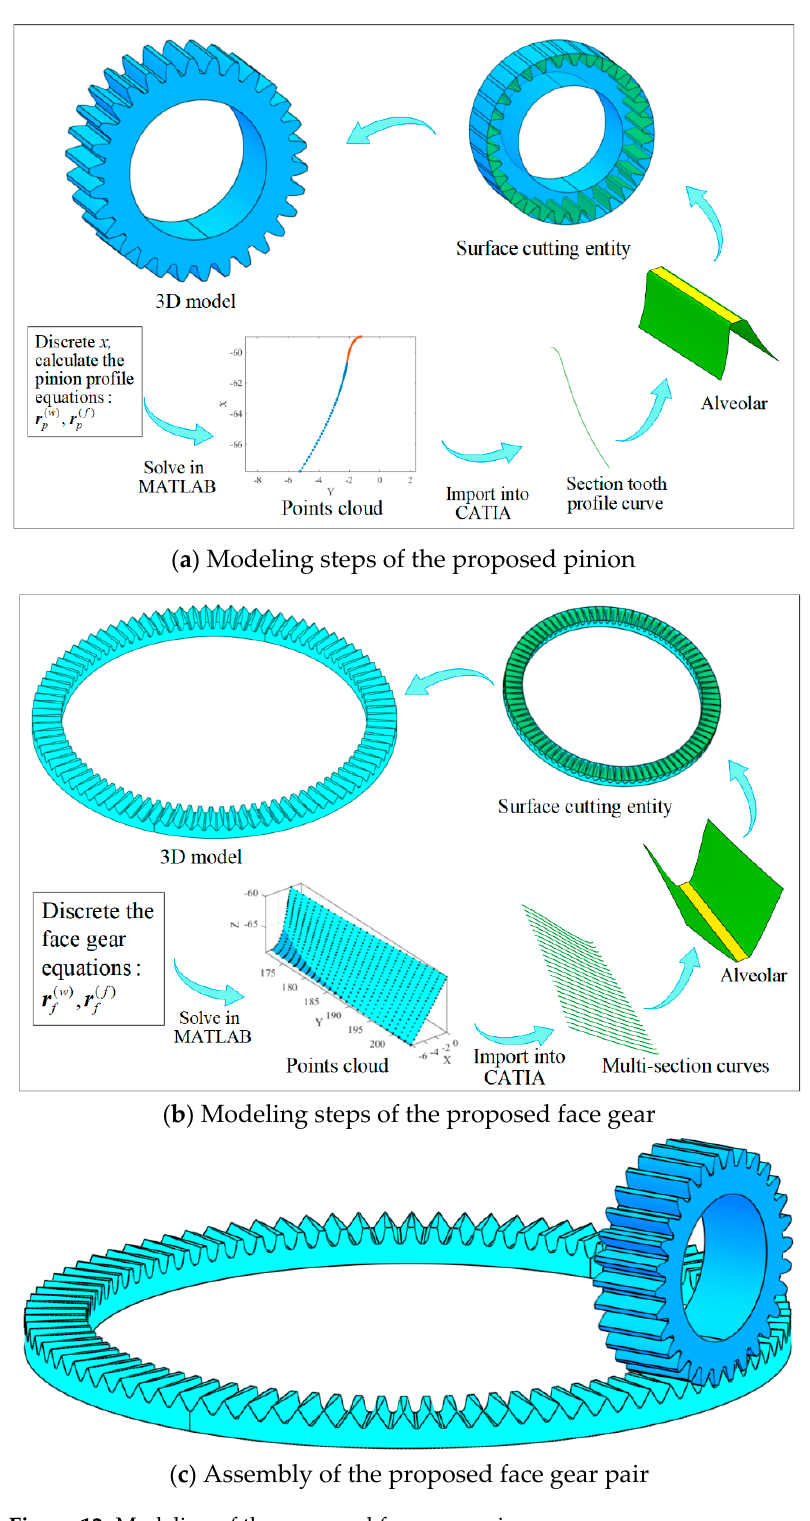
Figure 12. Modeling of the proposed face gear pair.